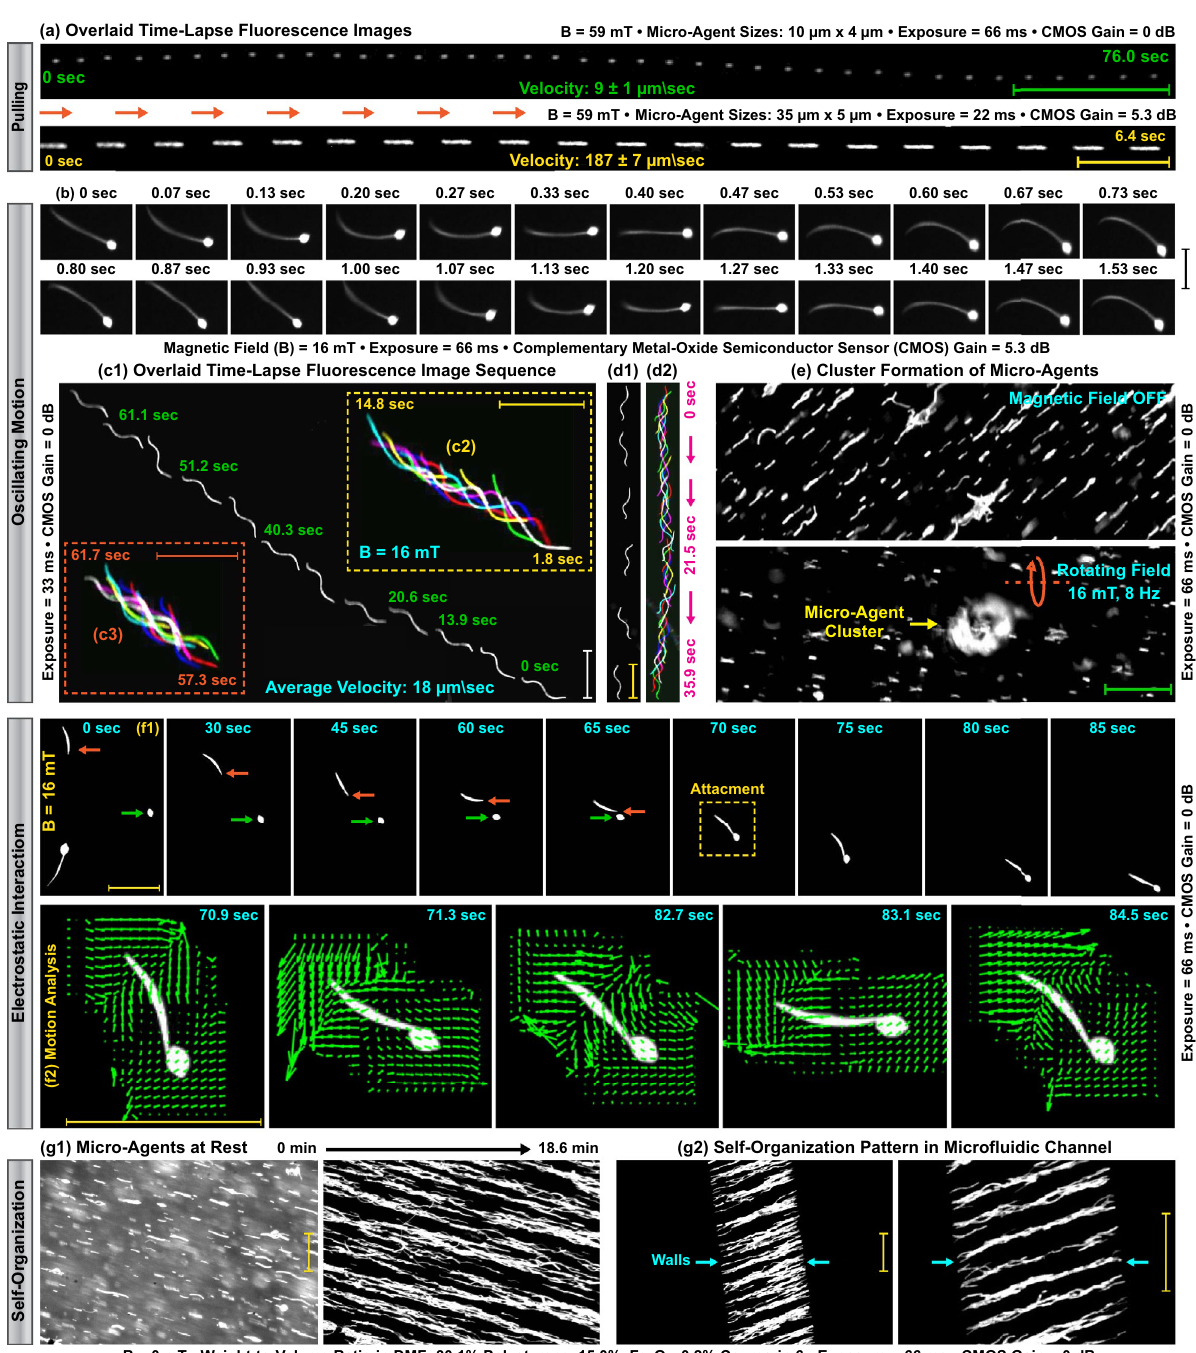
Figure 2. Single-band fluorescence microscopy for visualizing magnetic micro-agents labeled with coumarin 6. ( a ) Time-lapse image shows forward motion of the micro-agents by magnetic pulling. ( b ) Snapshot sequence demonstrates the oscillating motion of the micro-agent. ( c1 ) and ( d1 ) Overlaid fluorescence images show the diagonal and vertical movement of the micro-agents, respectively. ( c2 ), ( c3 ), and ( d2 ) Oscillating motion patterns of the micro-agents. ( e ) Aggregation of the micro-agents by a rotating magnetic field. ( f1 ) Attachment of the micro-agents by electrostatic interaction. ( f2 ) Vector field expresses the motion of the attached micro- agents analyzed using Lucas-Kanade optical flow. ( g1 ) and ( g2 ) Self-organization of the micro-agents in a reservoir and a microfluidic channel, respectively. Scale bar 100 µ